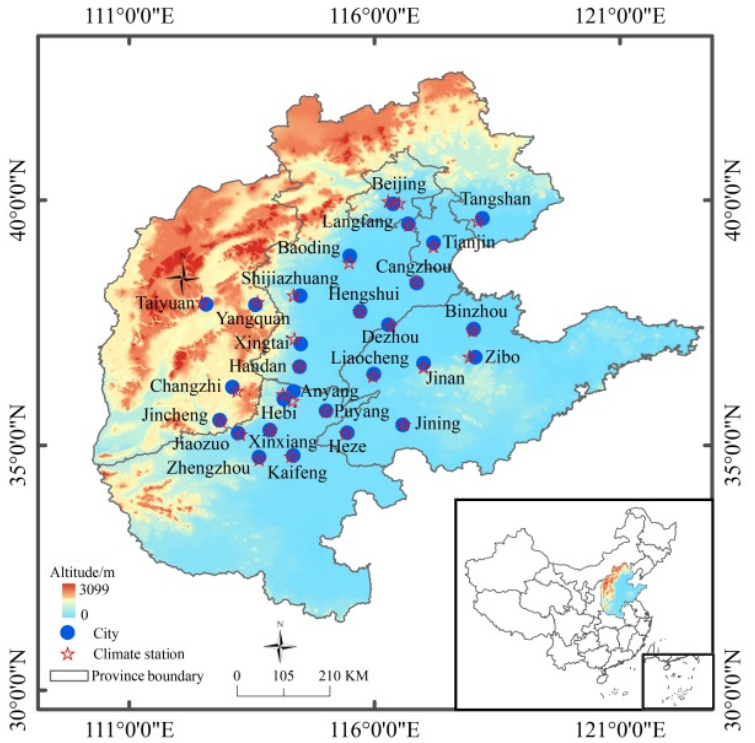
Figure 1. Locations of the 28 cities comprising the air pollution transmission channel in the Beijing– Tianjin–Hebei (BTH) area and regional meteorological stations.